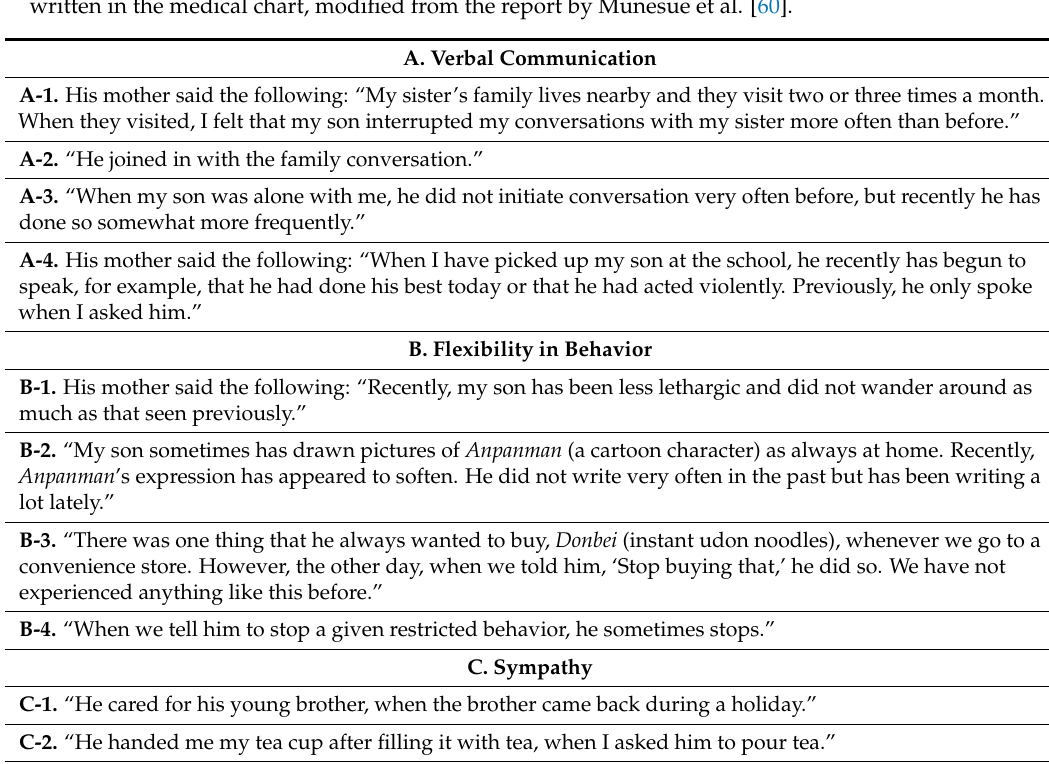
Table 2. Examples of episodes regarded as reciprocal social interactions. The descriptions of participants’ behaviors in the oxytocin group were obtained from the play and interview sessions written in the medical chart, modified from the report by Munesue et al.